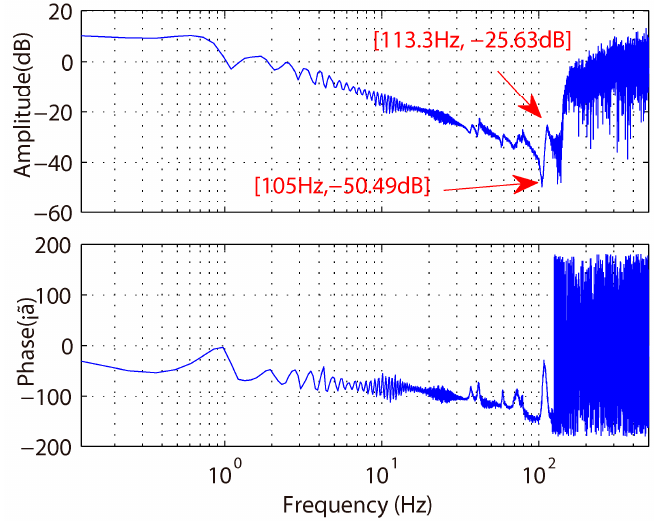
Figure 3. Open-loop frequency characteristic curve of pitch axis velocity.